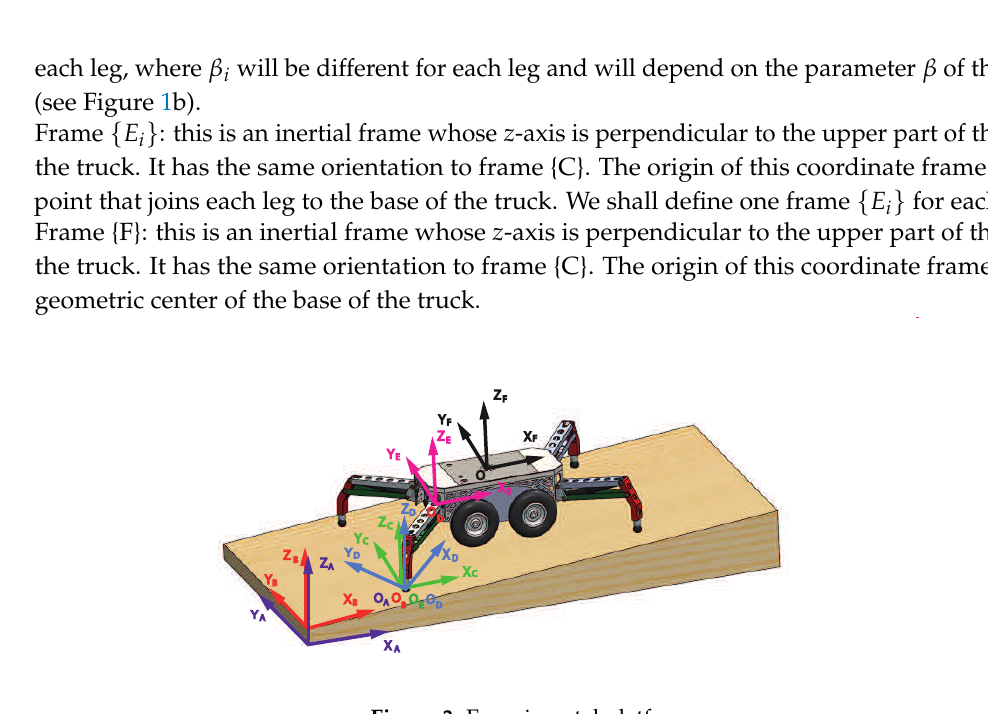
Figure 3. Experimental platform.